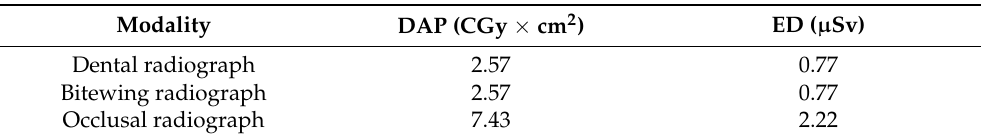
Table 1. Dose area product (DAP) and effective dose (ED) of dental, bitewing and occlusal radiographs executed with tube-head X-ray machines between 2002 and 2020 in patients aged up to 18 years.